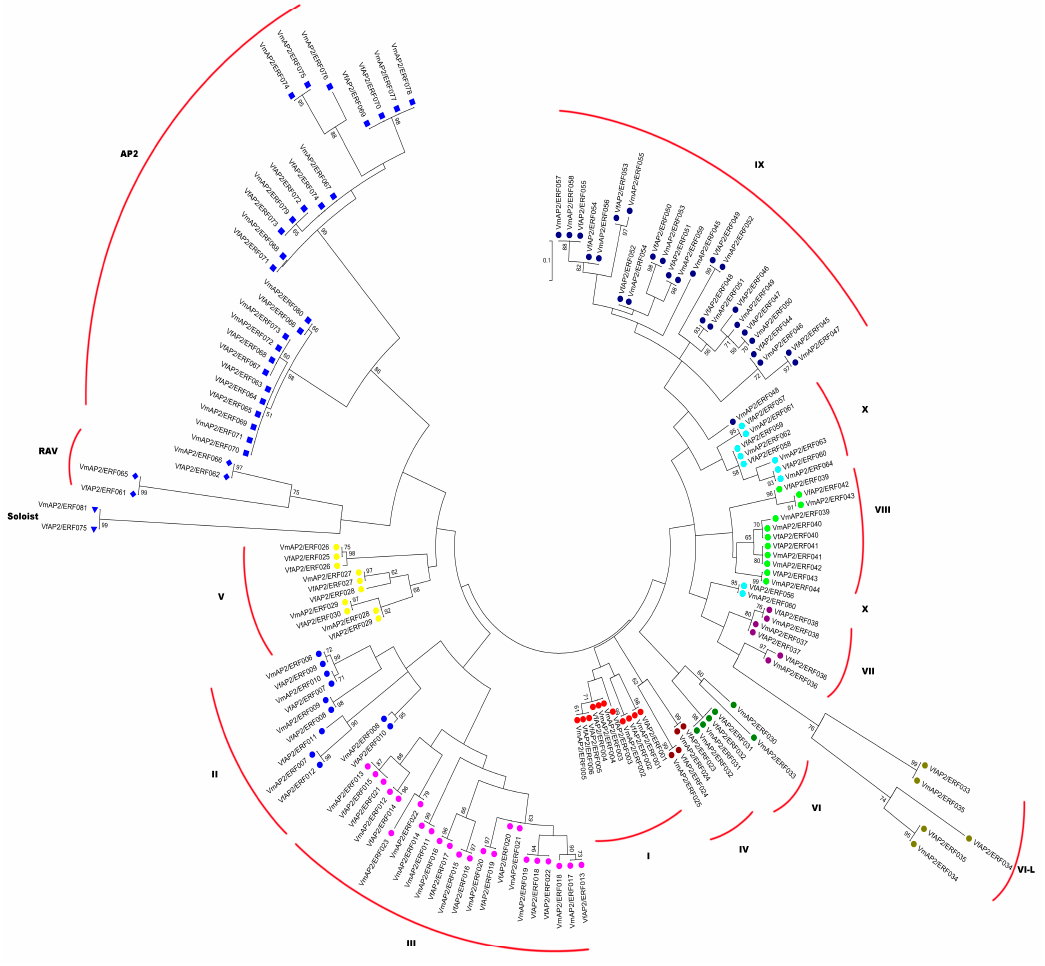
Figure 1. Phylogenetic analysis of APETALA2/ethylene-responsive element binding factor (AP2/ERF) superfamily proteins between Vernicia fordii and Vernicia montana . An unrooted maximum-likelihood (ML) phylogenetic tree was constructed using MEGA5. Bootstrap value >50% was shown in phylogenetic tree. AP2/ERF proteins were classified into different families and groups.